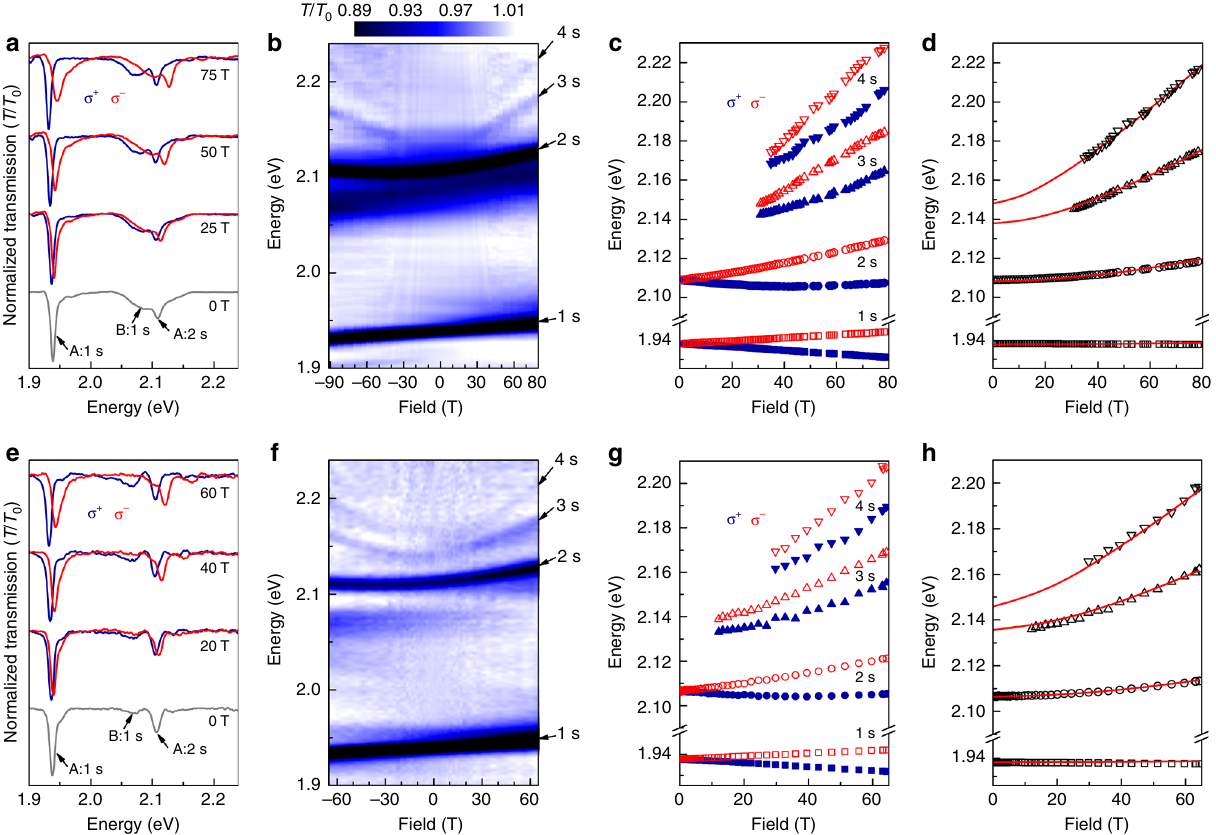
Fig. 2 Magneto-optical spectroscopy of monolayer MoS 2 . a Normalized σ ± polarized transmission spectra through monolayer MoS 2 encapsulated in hBN (sample 1), at 0, 25, 50, and 75 T. b Intensity map showing all the transmission spectra from (cid:4) 91 T to + 80 T. The excited 2 s , 3 s , and 4 s Rydberg states of the neutral A exciton are visible. c Energies of the ns excitons for both σ ± polarizations. d The average energies of the σ ± transitions for each ns exciton state. Solid curves show model calculations ( m structure (sample 2), acquired to ± 65 T. In this structure the B:1 s exciton is less pronounced, and the A:4 s exciton is more clear. Best fi ts are obtained using very similar parameter values ( m